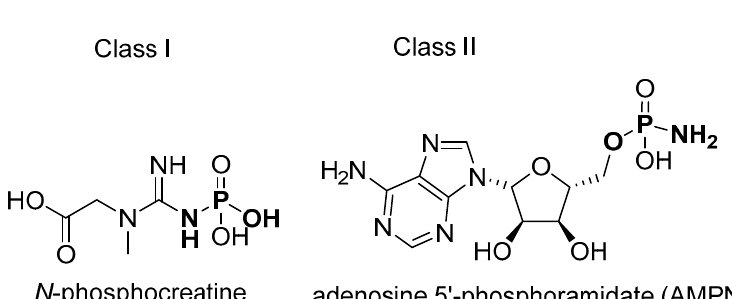
Figure 1. Phosphoramidates (bold font) are traditionally divided into two classes of compounds. Compounds of class I are characterized by the presence of terminal P–OH group (e.g., phosphagen— N -phosphocreatine). Compounds of class II are characterized by the presence of the accessible terminal P–NH 2 group (e.g., adenosine 5 ′ -phosphoramidate).